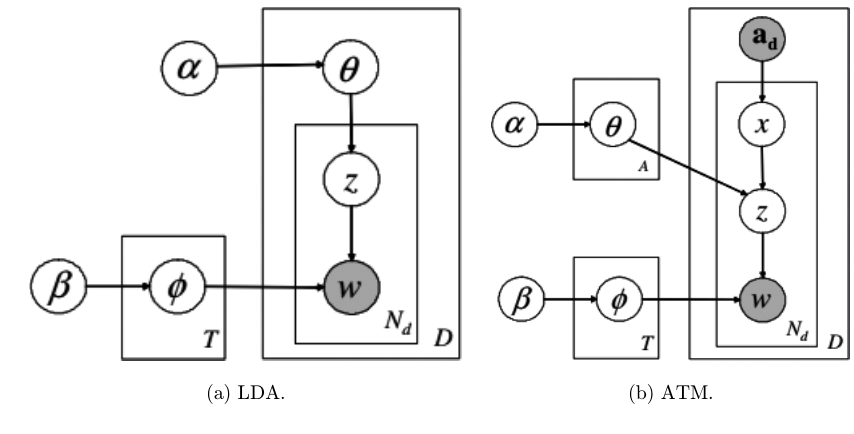
Fig. 1. Text mining methods: LDA and